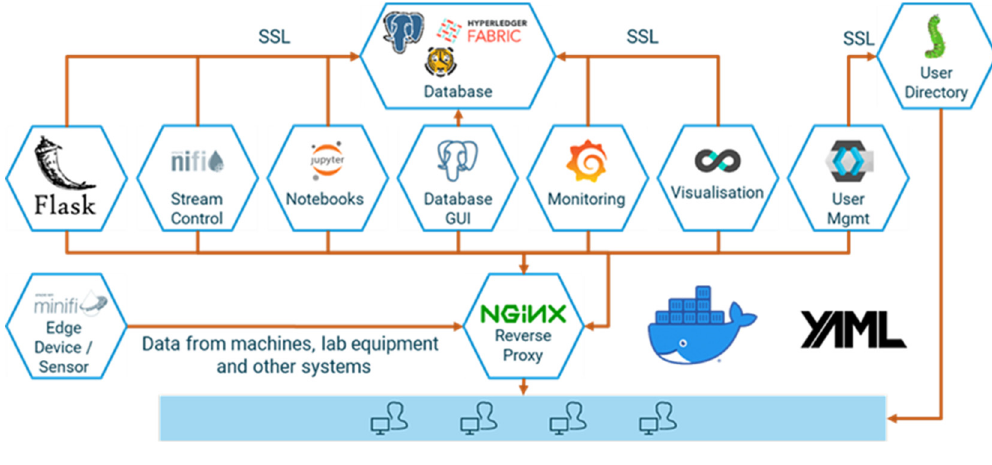
Figure 2. d ‐ scover@’s underlying open ‐ source tech ‐ stack. Figure 2. d-scover@’s underlying open-source